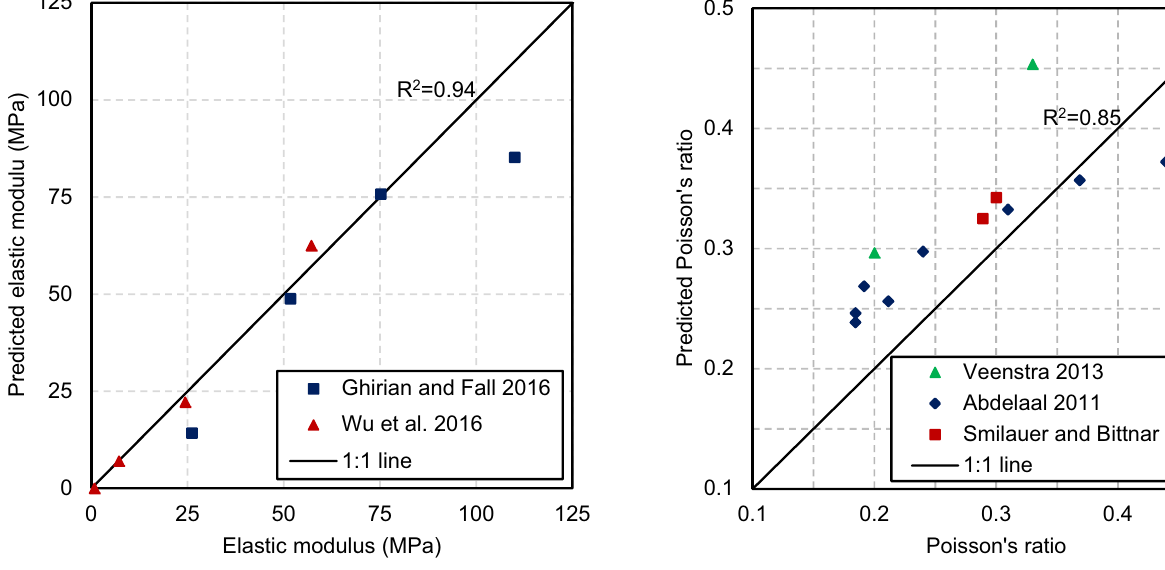
Fig. 5 Experimental versus predicted values of Poisson’s